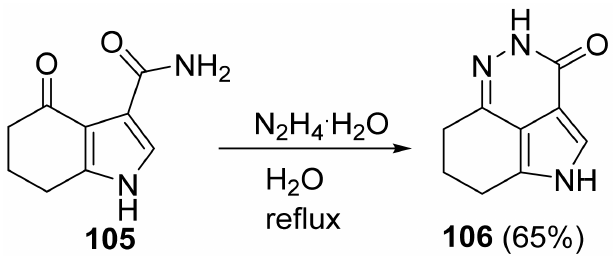
Scheme 20. Formation of a tricyclic pyrrolo fused